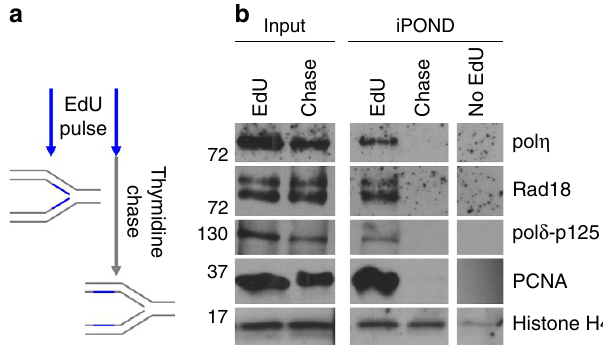
Figure 1 | Human pol g is recruited to replication forks during unchallenged S phase. ( a ) Scheme for the iPOND procedure: MRC5-V1 cells were pulse-labelled with EdU for 10min. Cells were then crosslinked and harvested immediately or after a 1h thymidine chase to allow replication forks moving away from the labelled DNA. Biotin was conjugated to EdU by click chemistry before cell lysis and chromatin fragmentation. EdU-containing DNA and associated proteins were purified on streptavidin beads. ( b ) Input and EdU-associated proteins (iPOND) were analysed by western blot using the indicated antibodies. No EdU: negative control processed as described in a but without EdU